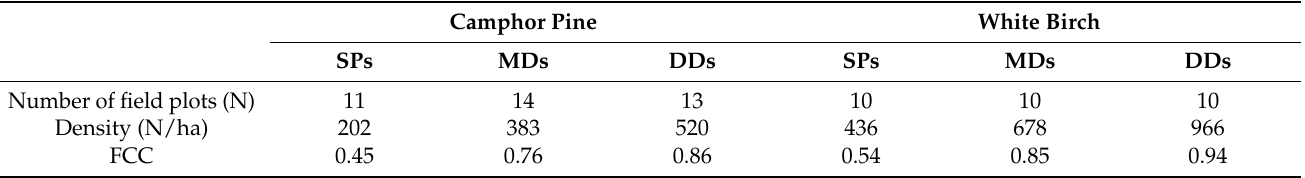
Table 1. Statistical information of field plots including the number of field plots, stands density of field plots, and FCC of camphor pine and white birch. FCC refers to the mean forest-canopy closure of field plots. SPs is the abbreviation of sparse plots; MDs is the abbreviation of medium density plots; DDs refers to dense plots.